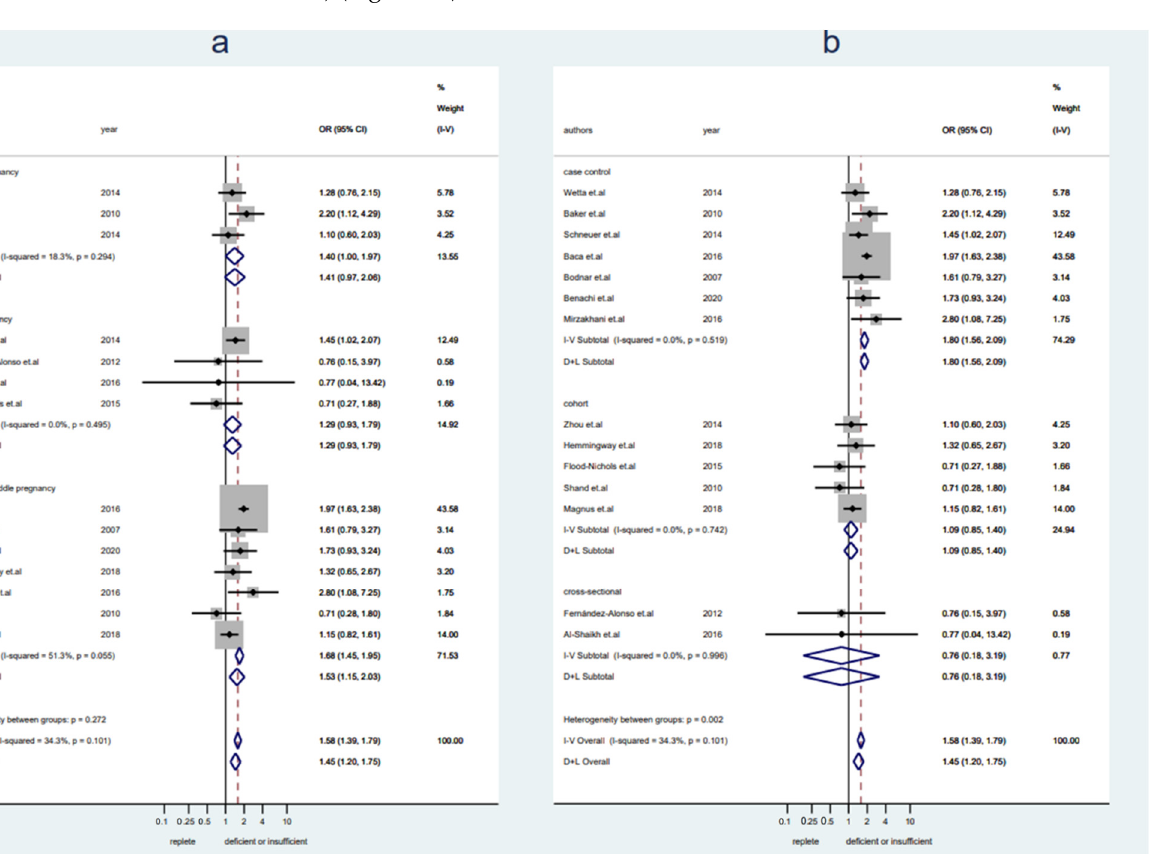
Figure 1. Studies evaluating replete vitamin D levels versus insufficient or deficient vitamin D levels. ( a ): Studies were stratified by gestational weeks (early, middle, and early and middle not specified); ( b ): studies were stratified by the study design.